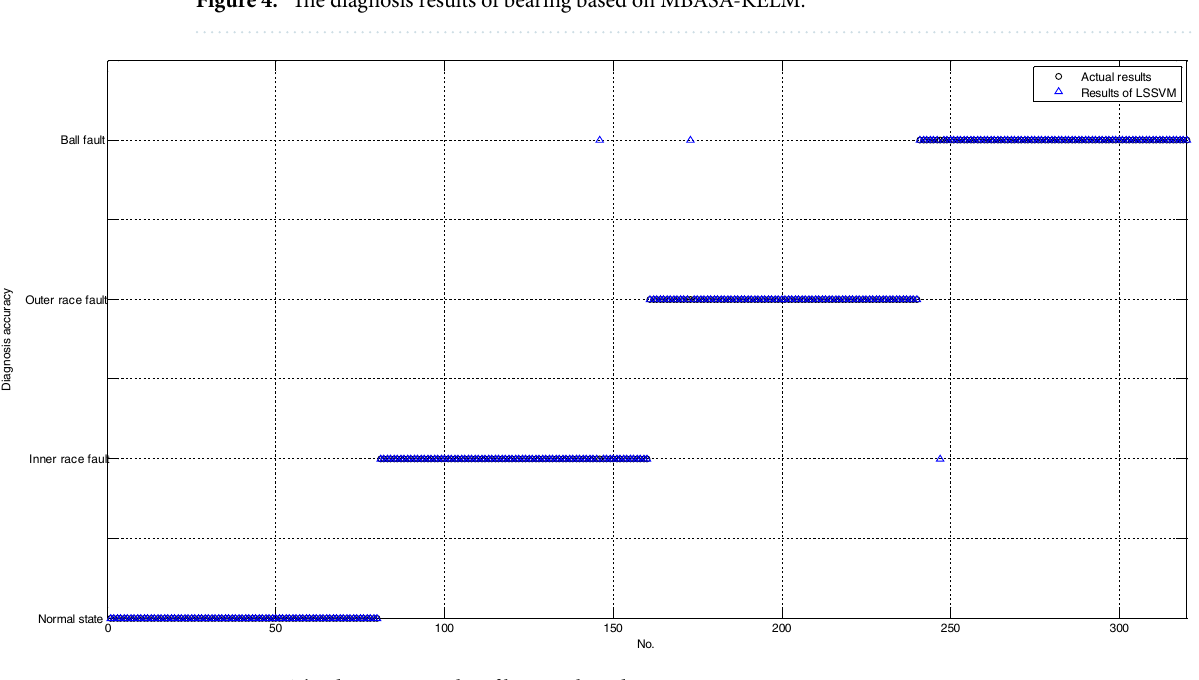
Figure 5. The diagnosis results of bearing based on